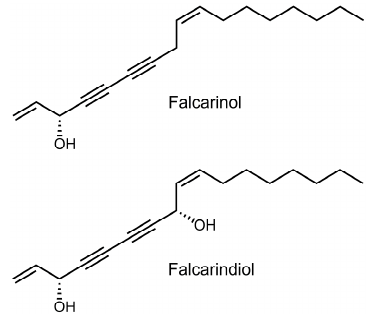
Figure 1. Chemical structures of (3 R ,9 Z )-1,9-heptadecadiene-4,6-diyne-3-ol (falcarinol; FaOH), and (3 R ,8 S ,9 Z )-1,9-heptadecadiene-4,6-diyne-3,8-diol (falcarindiol, FaDOH) tested in colorectal cancer (CRC) primed rats.